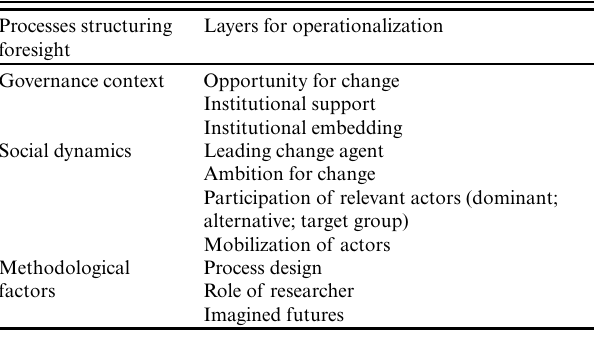
Table 1 . Processes structuring